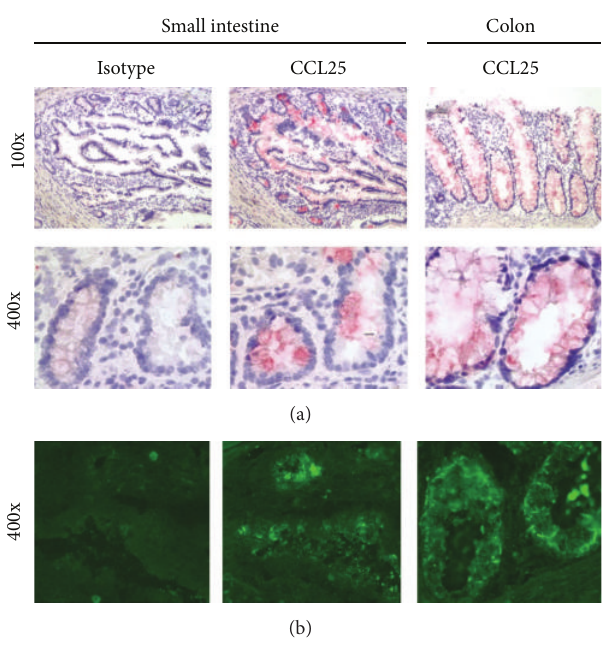
Figure 2: CCL25 protein is expressed in healthy human colon. Frozen sections of healthy human colon and small intestine were stained with CCL25 and isotype control antibodies. CCL25 protein was detected in epithelium in both colon and small bowel, as determined by IHC ((a), red color) and immunofluorescence ((b), green color). Magnification 100x (top row of (a)), 400x (bottom row of (a) and